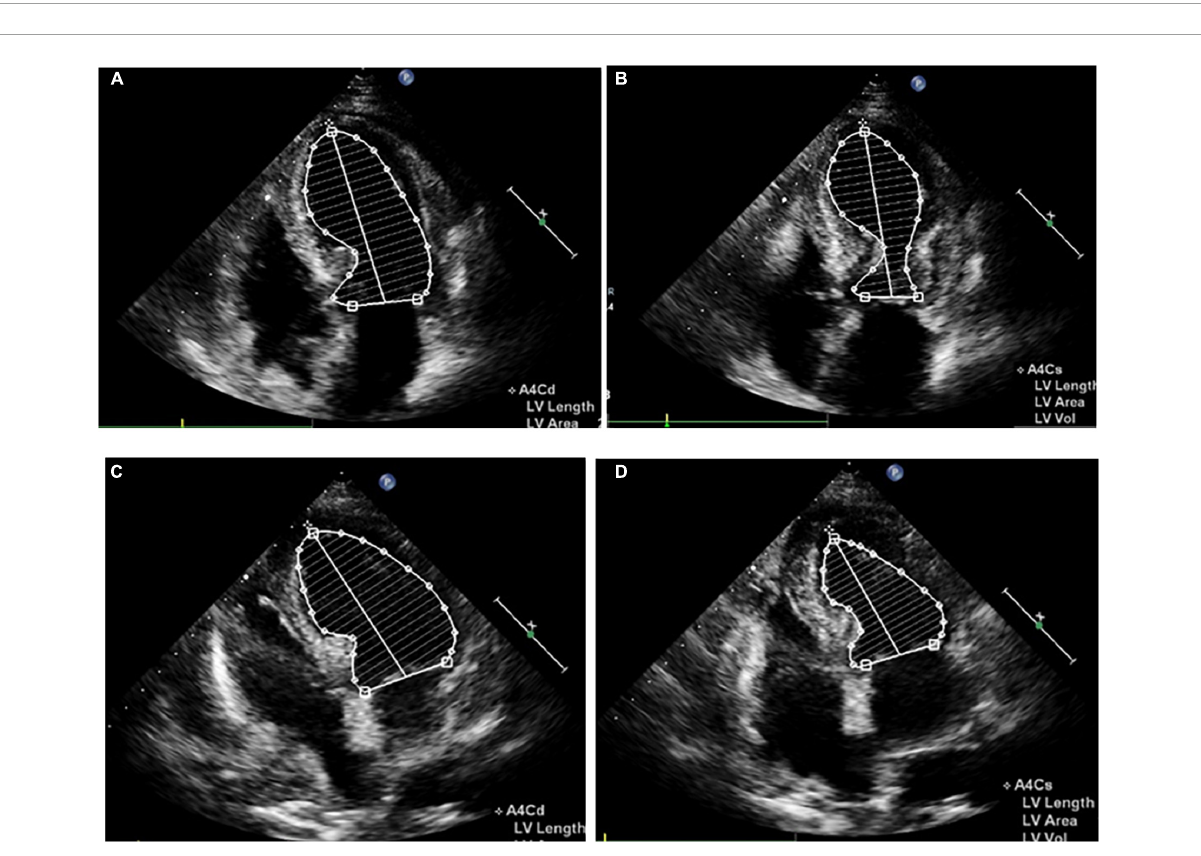
FIGURE2 Apical four-chamber view echocardiogram reveals apical dyskinesis and basal to midventricular hyperkinesis (A,B) , as well as apex systolic function improvement (C,D) . (A,C) Diastole. (B,D) Systole.